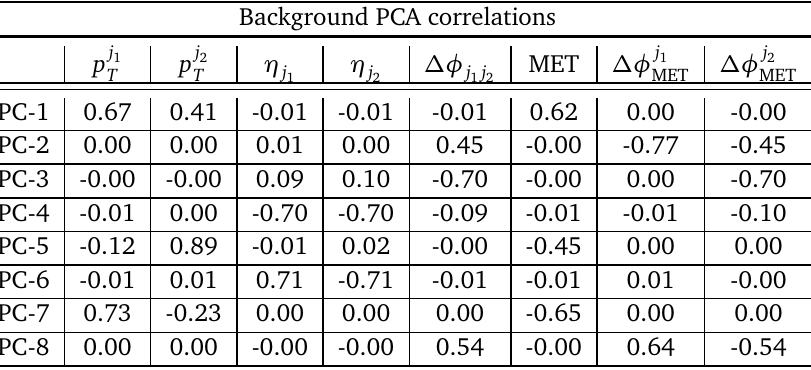
Table B1: PCA original feature to principal component correlations for the SM back- ground (rounded to 2